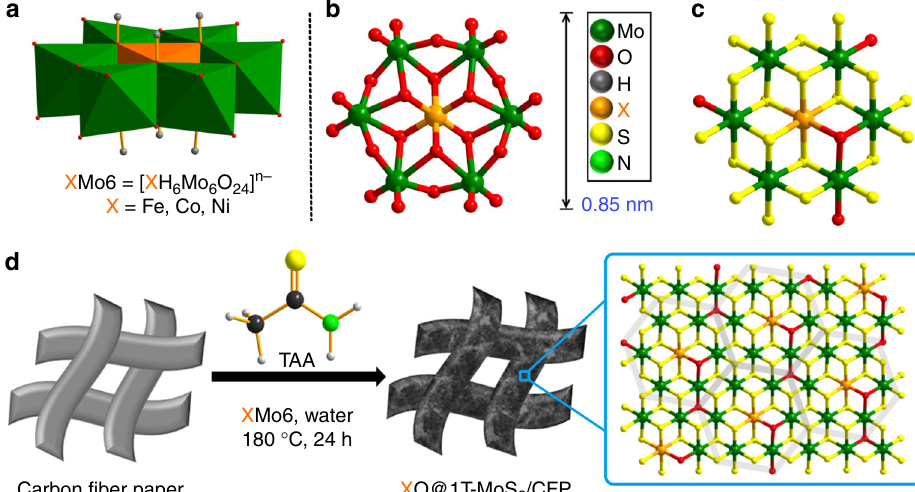
Fig. 1 Structure of POM precursors and preparation of the XO@1T-MoS 2 nanosheets. a Polyhedral representation of the XMo 6 precursors. b Ball and stick representation of the XMo 6 precursors. c The mode structure of XO@1T-MoS 2 . d Schematic illustration of the preparation of atomic scale transition metal and oxygen co-doped 1T-MoS 2 nanosheets on carbon fi ber paper (CFP), XO@1T-MoS 2 /CFP, by incomplete sulfuration of XMo 6 (green: Mo; yellow: S; orange: transition metal X; red: